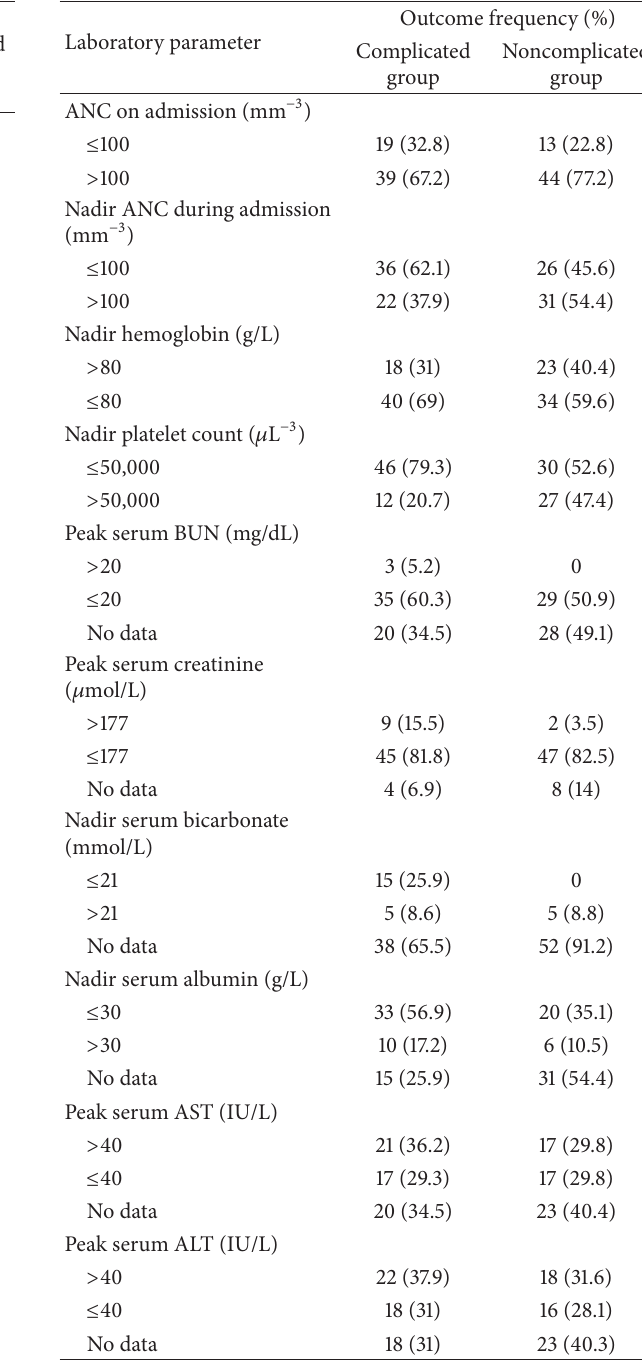
Table1:Baselineclinicalcharacteristicsoffebrileneutropeniacases. Table 2: Laboratory parameters of febrile neutropenia